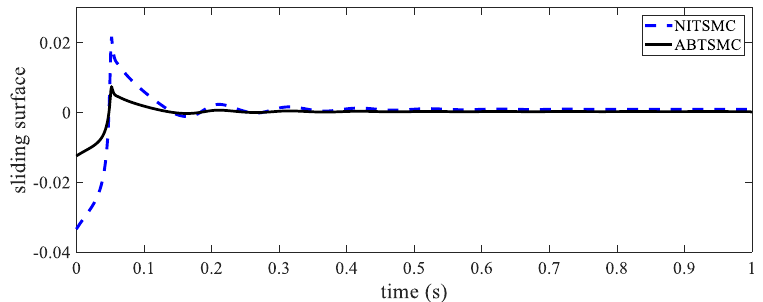
Figure 6. Sliding surfaces of ABTSMC and NITSMC.